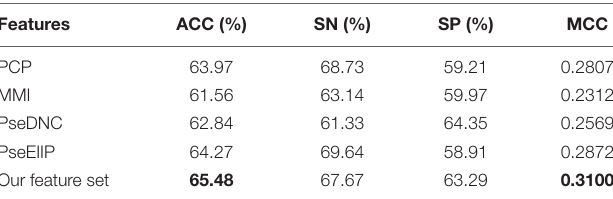
TABLE 2 | Five-fold cross validation results of the proposed feature set with other sequence-based feature descriptors.